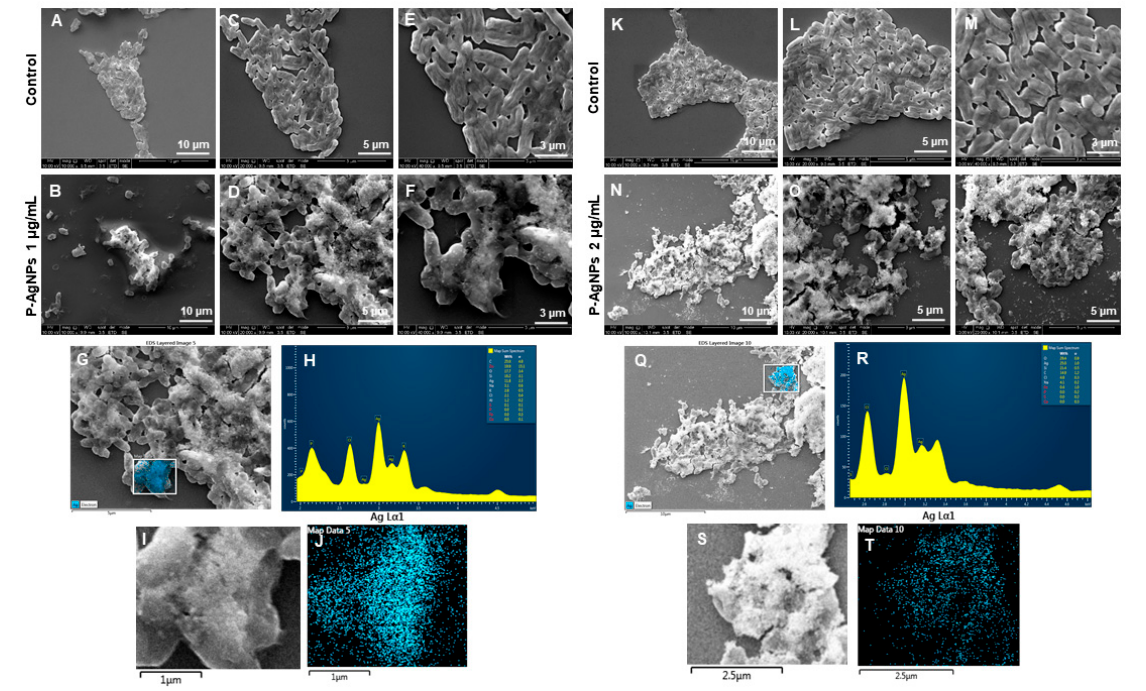
Figure 12. SEM analysis of P. aeruginosa cells after treatment with P-AgNPs. ( A – E ) Control cells and ( B – F ) P-AgNPs treated cells with 1 μ g/mL at different scales. ( G ) Scanned image of treated cells, ( H ) EDX spectrum of the chosen area-showing peak for silver element. ( I , J ) elemental mapping of the selected area showing silver elements in the treated cells (blue color). ( K – M ) Control cells and ( N – P ) cells treated with 2 μ g/mL of P-AgNPs at different scales. ( Q ) Scanned image of treated cells, ( R ) EDX spectrum of the chosen area showing peak for silver element, ( S , T ) elemental mapping of the selected area showing silver elements in the treated cells (blue color).